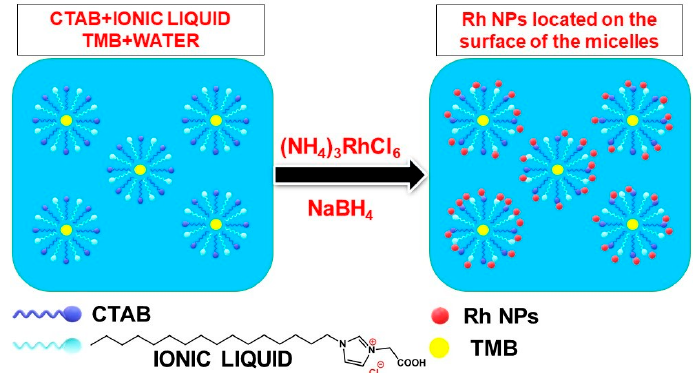
Figure 10. Synthesizing Rh NPs by a CTAB-ionic liquid micellar template (Yao et al. [98]), redrawn by the authors from the reference.